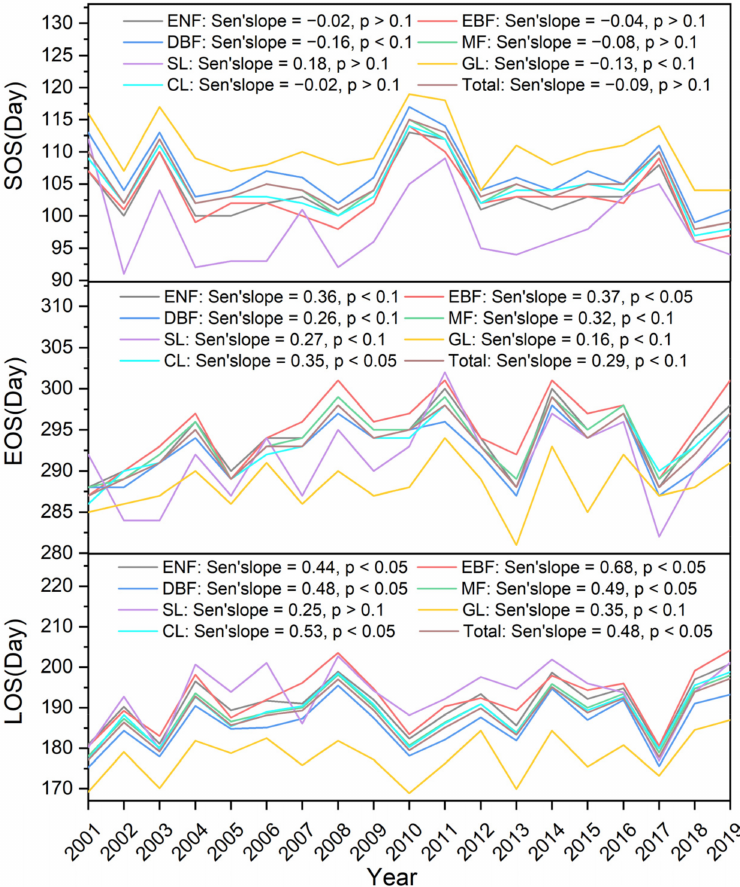
Figure 6. Interannual variations and significance of the mean phenology metrics for the entire study area and the areas covered by different vegetation types. The unit of Sen’s slope is